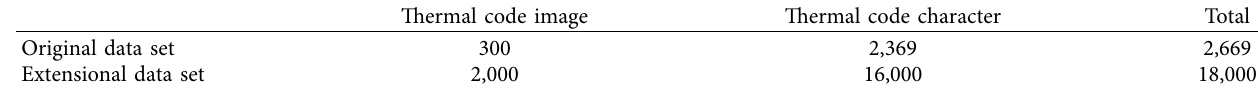
Table 1: Image data expansion results.